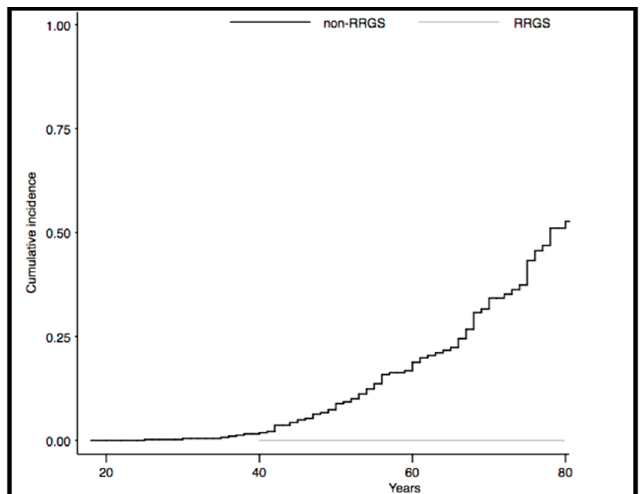
Figure 3. All-cause mortality cumulative incidence in females with Lynch syndrome comparing risk reducing gynecological surgery and non-risk reducing gynecological surgery: All-cause mortality cumulative incidence was 0.0% for risk reducing gynecological surgery vs. 52.7% for non-risk reducing gynecological surgery ( p = not assessable).